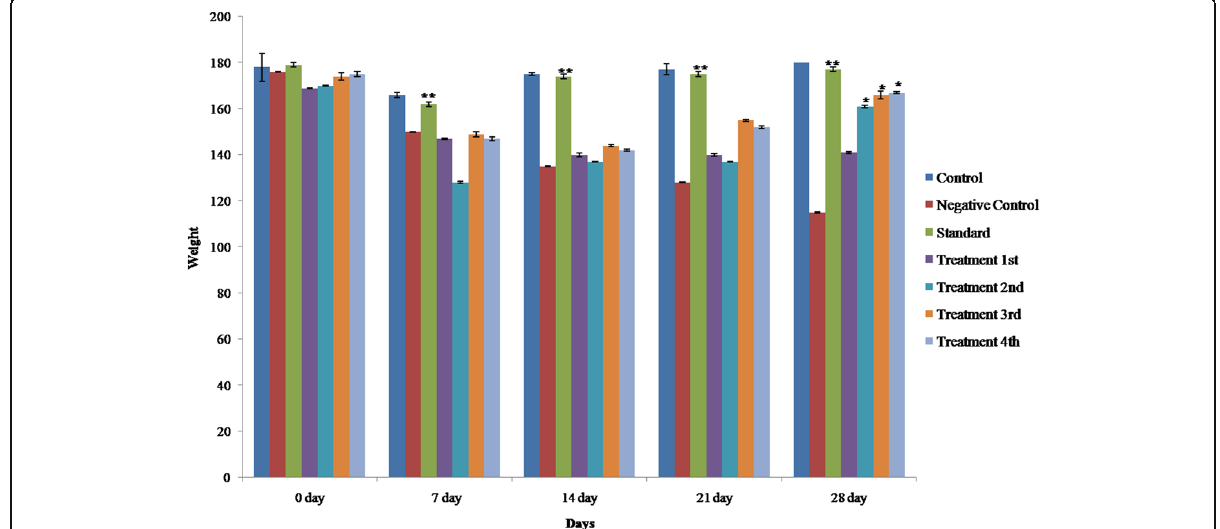
Fig. 5 Effect of PH extracts on weight of animals. Results are Mean ± S.E.M, n = 6 animals in each group. ANOVA, Dunnett ’ s test ** p < 0.001,*p<